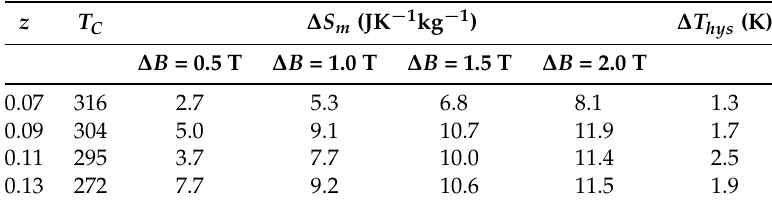
Figure 8. Magnetization as a function of temperature measured on heating and cooling in a magnetic field of 1 T for the Mn 1.00 Fe 0.95 − z Co z P 0.51 Si 0.45 B 0.04 compounds. The temperature sweep rate is 2 K/min. Table 1. Curie temperature ( T C ) derived from the magnetization curves measured on heating, the isothermal entropy change ( ∆ S m ) derived from the isofield magnetization curves in a field change of 0.5, 1.0, 1.5 and 2.0 T, thermal hysteresis ( ∆ T hys ) derived from the magnetization curves measured in 1 T upon cooling and heating for the Mn 1.00 Fe 0.95 − z Co z P 0.51 Si 0.45 B 0.04